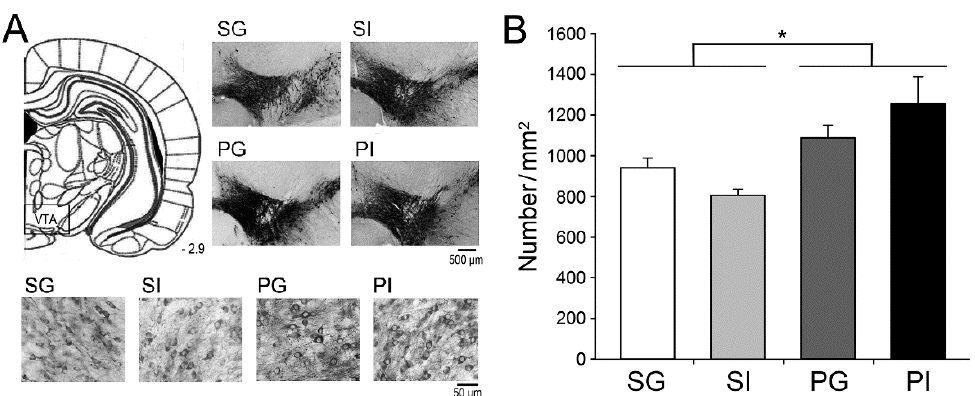
Figure 5. Density of dopaminergic neurons in the VTA. ( A ) Dopaminergic neurons in the VTA were revealed using tyrosine hydroxylase (TH) immunohistochemistry. ( B ) The density of TH-positive neurons in VTA was measured. Results are mean ± SEM ( n = 5–10 mice per group). * p < 0.05. Reductions in GABAergic cortical neurons, especially parvalbumin (PV)-positive neurons, are